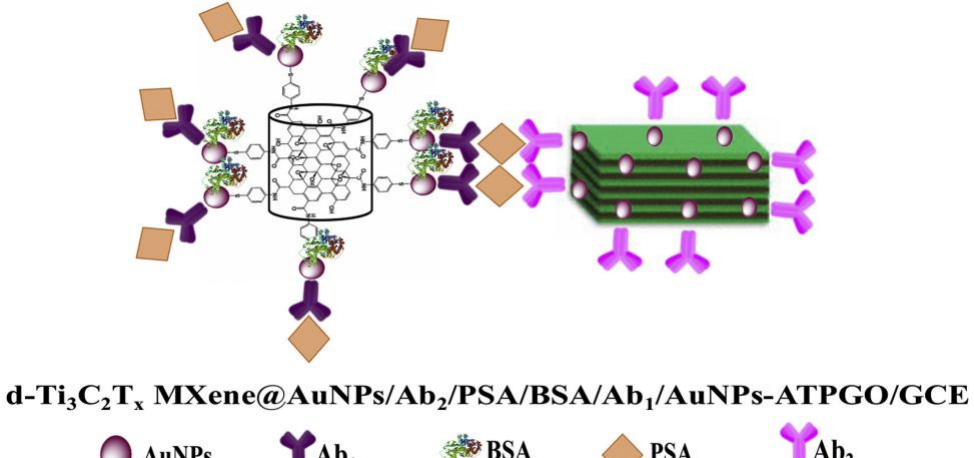
Figure 5. Schematic illustration of sandwich-type immunosensor for quantitative detection of PSA. Reprinted with permission from Ref. [59]. 2020, Elsevier.